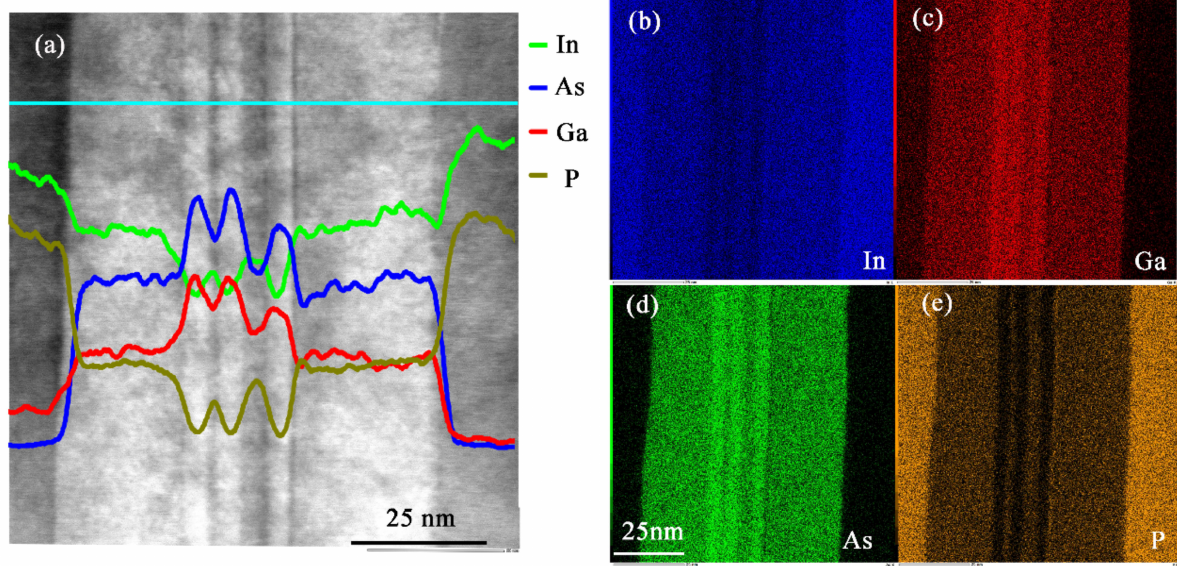
Figure 4. ( a ) EDS line scan over the whole SCH–MQW structure. The cyan line indicates the scanned range and position. ( b – e ) EDS surface scan of the element In, Ga, As, and